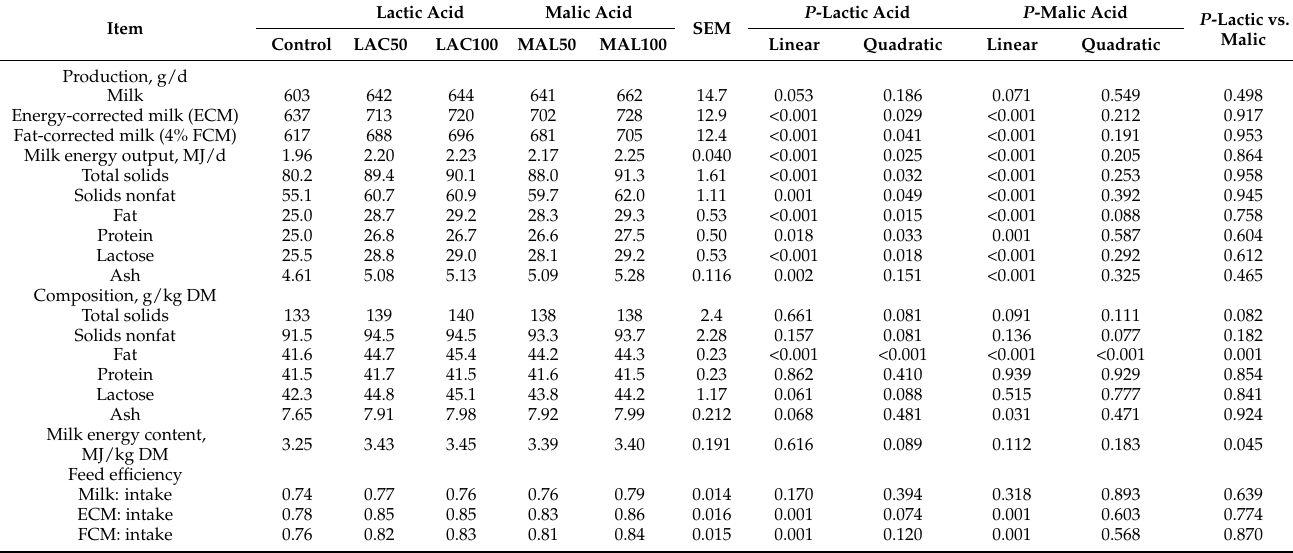
Table 4. Milk production, composition, and feed efficiency of lactating Farafra ewes fed a diet containing date palm leaves (DPL) ensiled without additives or ensiled with lactic acid or malic acid 1 .